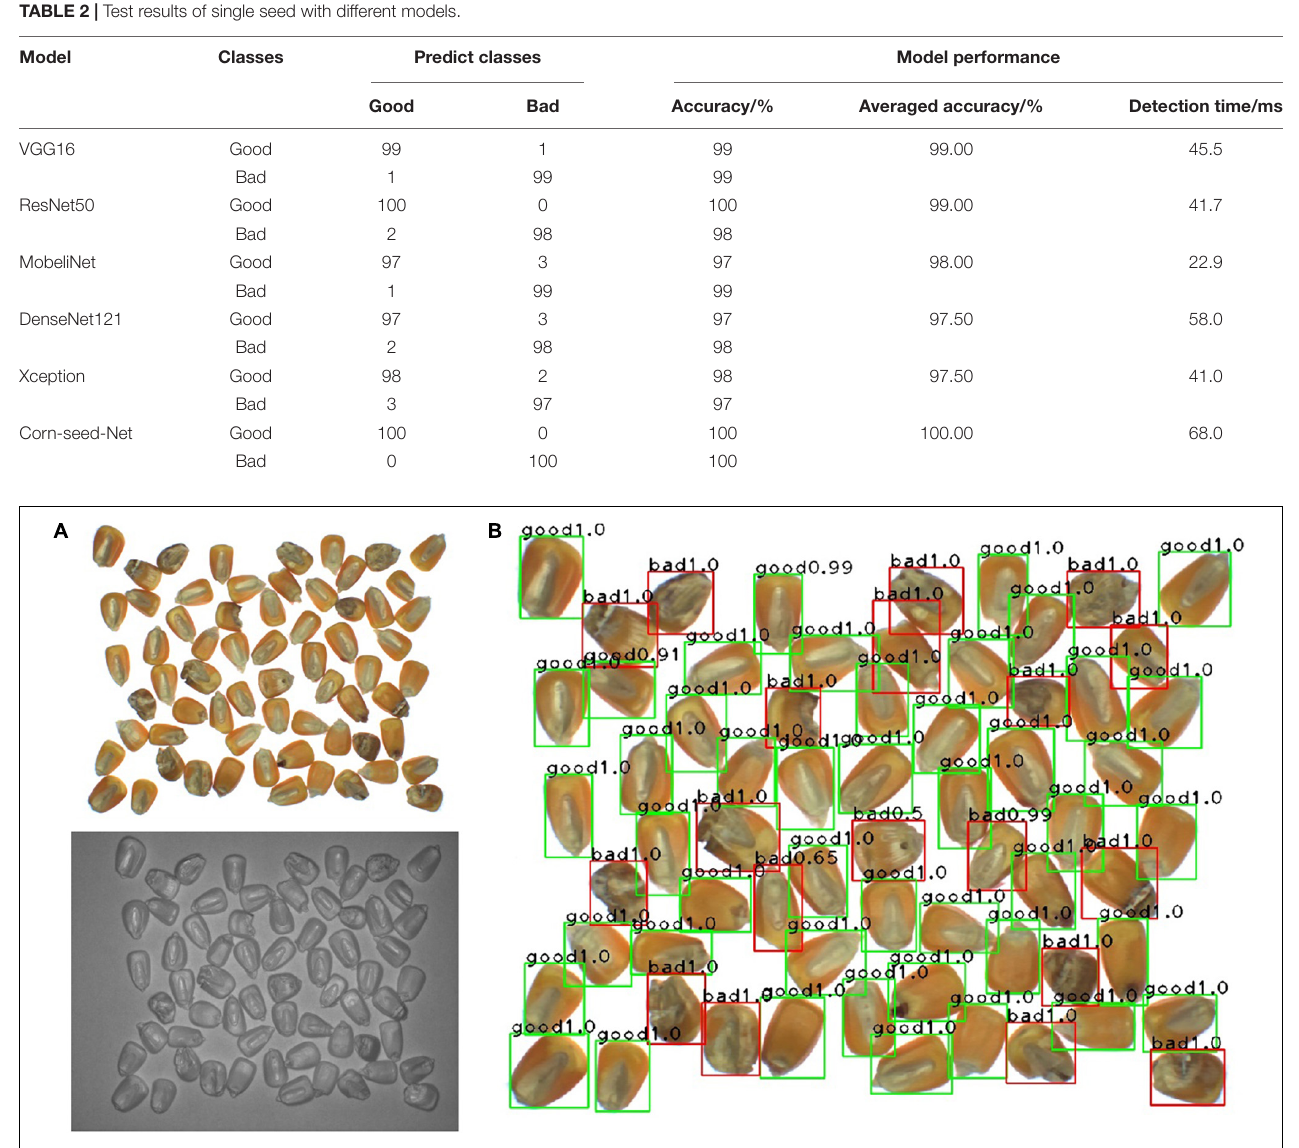
FIGURE 8 | (A) The original image and (B) object detection